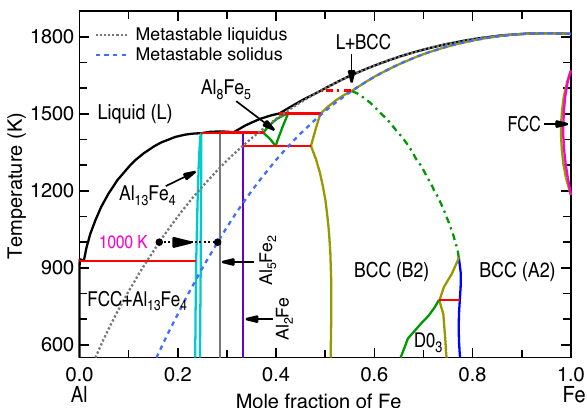
Figure 1. Calculated Al–Fe phase diagram based on CALPHAD modeling by Sundman et al. 9 . The metastable liquidus and solidus lines are plotted to analyze the formation of non-equilibrium phases from the supersaturated solution phase. One example at 1000 K is shown for phase equilibrium from the supercooled liquid with composition x Fe = 0.163 to the supersaturated BCC phase with x Fe = 0.281, then the composition 0.281 is used to calculate thermodynamic driving forces of IMCs at 1000 K; see Fig. 6.